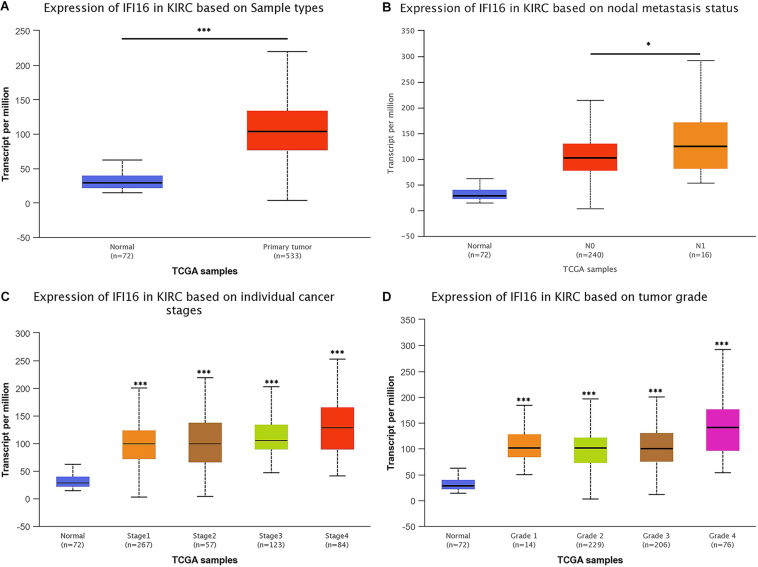
IFI16 mRNA expression and relationship with tumor stage, lymphatic metastasis, and histopathological grade in ccRCC (UALCAN). (A) Relative expression of IFI16 in ccRCC and normal tissues. (B) Relationship between IFI16 expression and lymphatic metastasis in ccRCC. (C) Relationship between IFI16 expression and tumor stage in ccRCC. (D) Relationship between IFI16 expression and histopathological grade in ccRCC. *P < 0.05, ***P < 0.001.